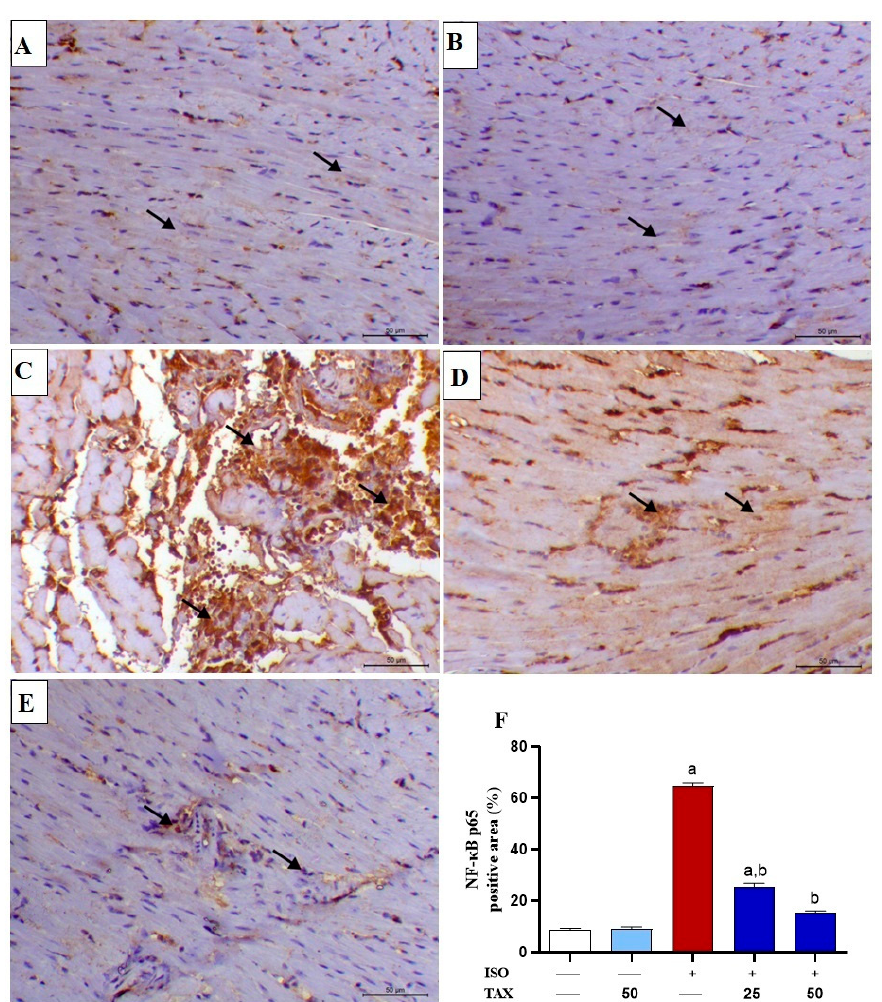
Figure 5. TAX attenuates ISO-induced myocardial NF- κ B p65 upregulation. Images of microscopic field of IHC labeled cardiac sections from ( A ) control and ( B ) TAX-treated mice showing mild expression of myocardial NF- κ B p65 (arrows designate positive immunostaining within the interstitial cells); ( C ) ISO-injected mice showing a marked increase in both cytoplasmic and nuclear levels of NF- κ B p65 antibody within myocytes (arrows designate marked expression within both degenerated fibers and inflammatory cells); ( D ) ISO-administrated mice pre-treated with 25 mg TAX demonstrating a decreased level of the nuclear NF- κ B p65 within the myocytes (arrows); and ( E ) ISO-administrated mice pre-treated with 50 mg TAX demonstrating a noticeably decreased expression of the nuclear NF- κ B p65 within the myocardial fibers (arrows) (IHC, X200, Scale bar = 50 µm). ( F ) Analysis of the relative intensities of the images of IHC labeled myocardial NF- κ B p65 showing a significant increase in ISO-injected mice and a significant reduction in mice pre-treated with both doses of TAX. Data are expressed as mean ± SEM, ( n = 6). Here, a indicates significant ( p < 0.05) vs. control, while b indicates significant ( p < 0.05) vs. ISO.